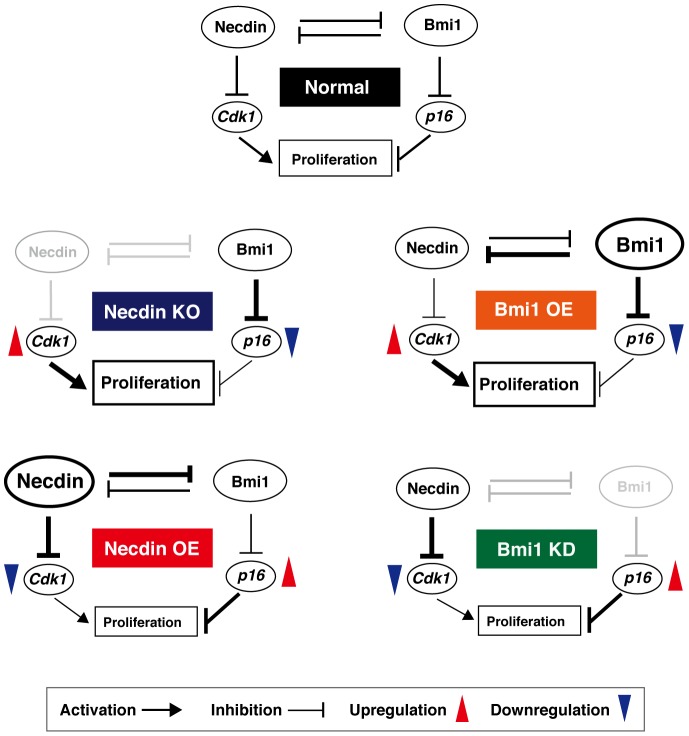
Antagonistic interplay between necdin and Bmi1.Data shown in Figures 6 and 7 were schematically presented. For details, see Discussion.